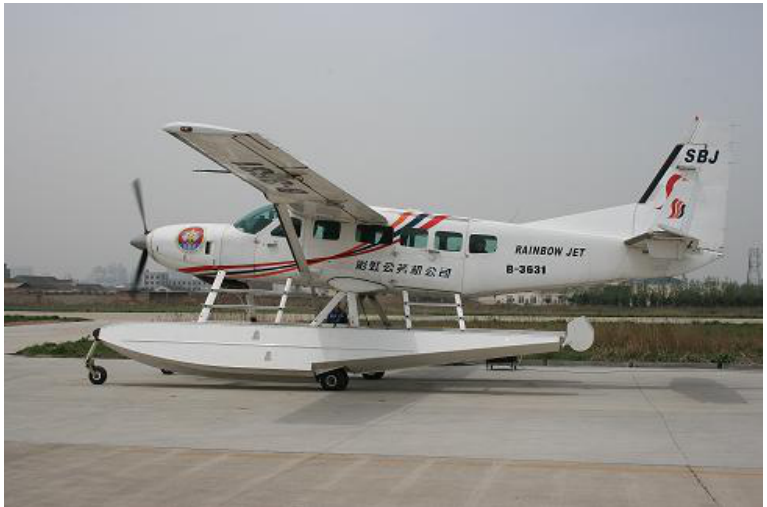
Figure 2. Cessna 208 fixed-wing small